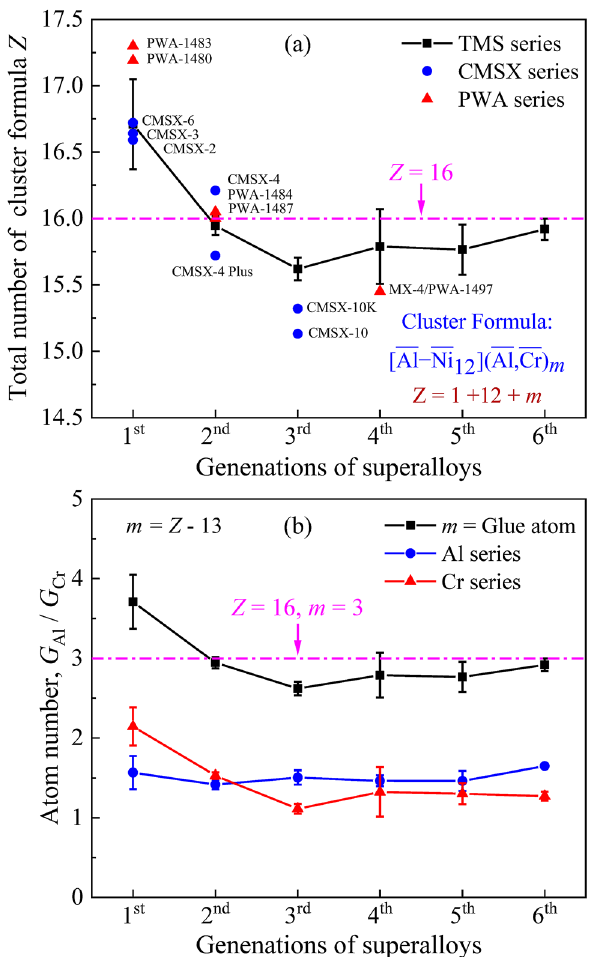
Figure 1. Variation of atom numbers in cluster formula with the developed generations of Ni-base SC superalloys. ( a ) The total atom number Z of the cluster formula; ( b ) the atom number of the Al series, Cr series at the glue atom sites, and the glue atom